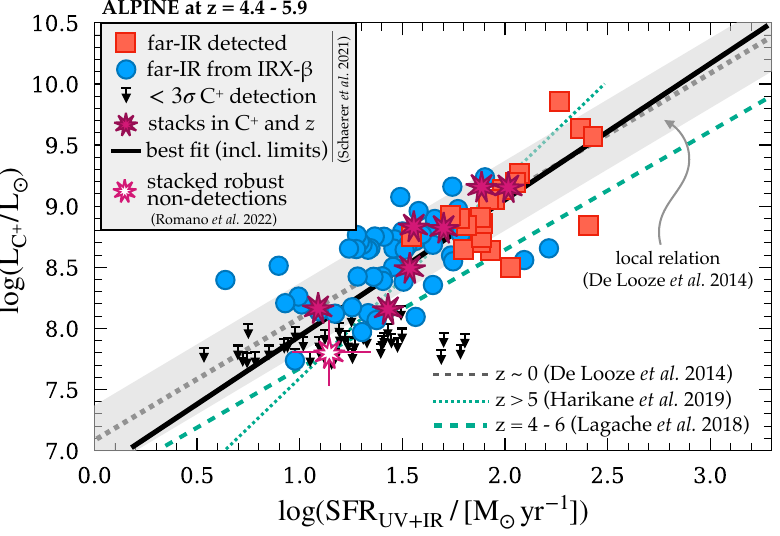
Figure 4. C + vs. total SFR (from UV + far-IR) relation derived from the ALPINE sample from Schaerer et al. [91]. Galaxies detected in far-IR are shown as red squares. For galaxies not detected in far-IR (blue circles), the far-IR luminosity is derived from the IRX − β relation from Fudamoto et al. [92]. C + non- detections at 3 σ are shown as black upper limits. The filled purple stars show stacked measurements (four bins of L C + and two bins in redshift). The empty purple star shows a stack from robust nondetections from Romano et al. [94]. The best fit (log ( L C + /L (cid:12) ) = α + β × log ( SFR/ [ M (cid:12) yr − 1 ]) with α = 6.61 ± 0.20 and β = 1.17 ± 0.12) is shown as a thick black line. The z = 4–6 relation from ALPINE is consistent with the relation derived from local galaxies (gray dashed line with shaded region (2 σ ); [45]). The predictions from the semianalytical model from Lagache et al. [77] (green dashed line) and the observations at z > 5 from Harikane et al. [96] (green dotted line) are also shown. Adapted from Ref.